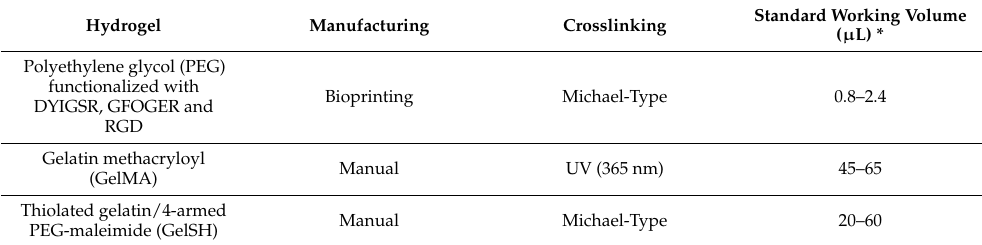
Table 2. 3D hydrogel systems assessed for BCa PDO